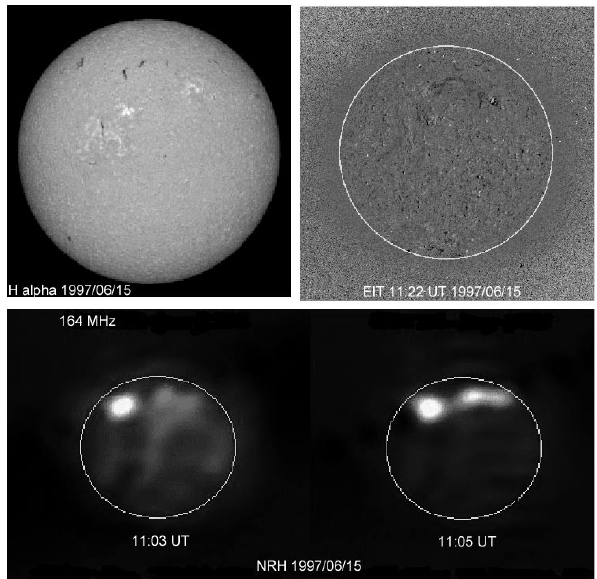
Fig. 2. Top left: EIT (195 ˚A) difference image at 14:22UT show- ing the development above the east limb of an eruptive prominence (seen first at 14:13UT). Top right: NRH observation at 164MHz showing on the east limb the extended radio loop-like source as- sociated with the CME development (as in, for example, Maia et al., 2000). The source on the southwest is a noise storm present all day long. Bottom: LASCO C2 and C3 difference images showing the development on both hemispheres (at polar angles (PA) 90 ◦ and 265 ◦ ) of CMEs which finally develop a partial halo feature in